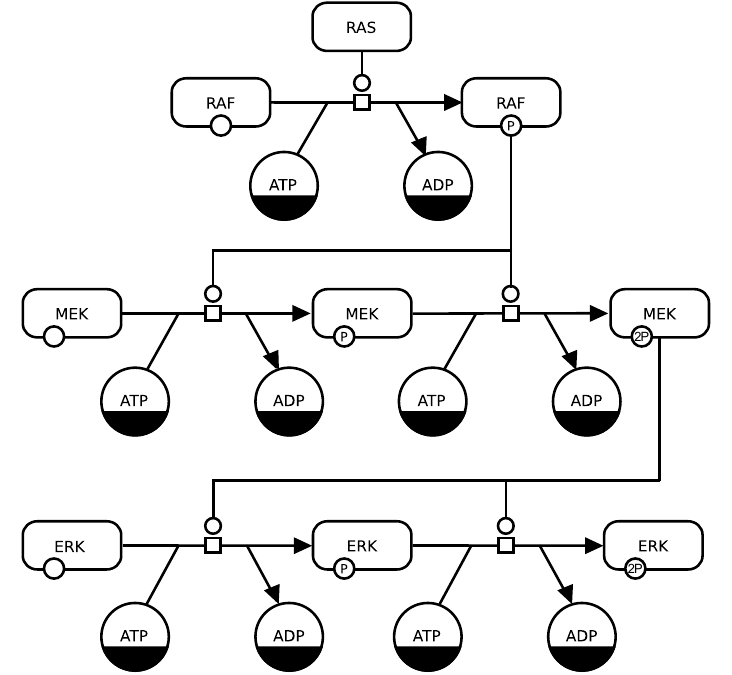
Figure 2.1: This example of a Process Description uses two kinds of entity pool nodes: one for pools of different macromolecules (Section 2.4.3) and another for pools of simple chem- icals (Section 2.4.2). Most macromolecule nodes in this map are adorned with state vari- ables (Section 2.3.2) representing phosphorylation states. This map uses one type of process node, the process node (Section 2.8.1), and three kind of connecting arc, consumption (Sec- tion 2.9.1), production (Section 2.9.2) and catalysis (Section 2.9.5). Finally, some entity pool nodes have dark bands along their bottoms; these are clone markers (Section 2.3.3) indicating that the same pool nodes appear multiple times in the